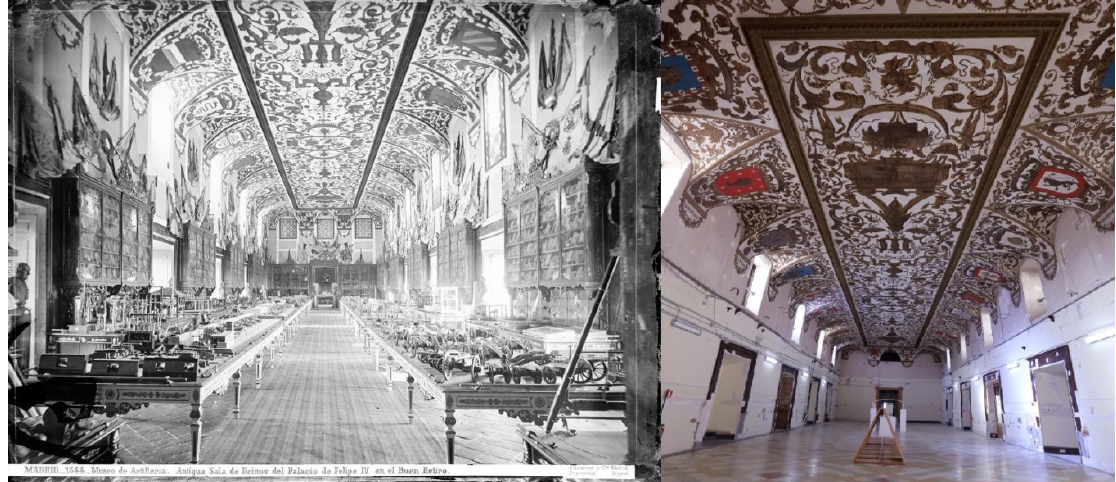
Figure 1. Salón de Reinos, Museo Nacional del Prado , Madrid, Spain. ( Left ), as Army Museum. Photo J. Laurent y Cia. Archivo Ruiz Vernacci. IPCE, Ministerio de Cultura y Deporte. ( Right ), before restoration. Photo Juan Aguilar, Ágora S.L.